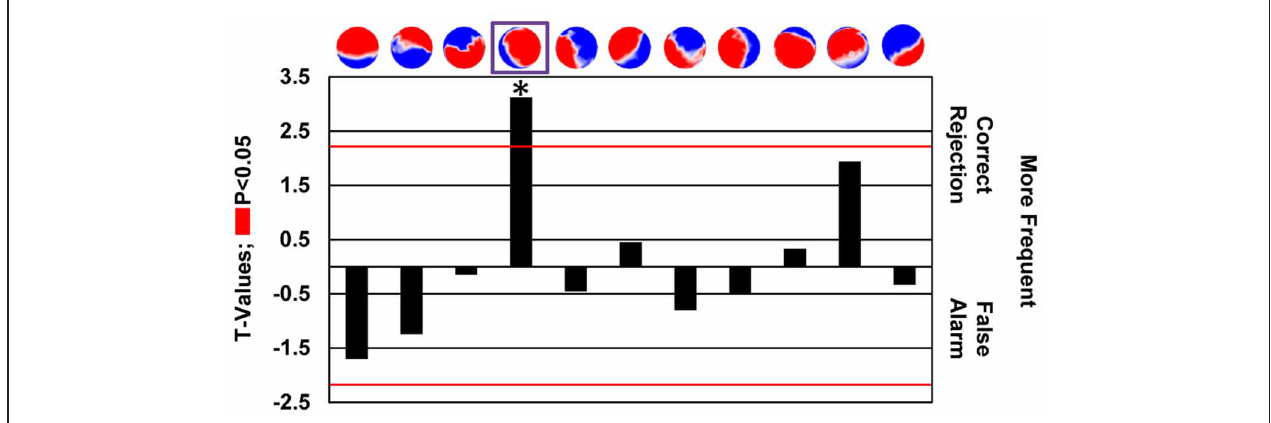
FIGURE 2 | Topographies of the prestimulus microstates as revealed by the cluster analysis. The map that significantly differentiated the correct rejections is framed in violet. The red lines indicate the t -test p < 0 . 05 significance threshold and an asterisk is placed where significance has been reached.